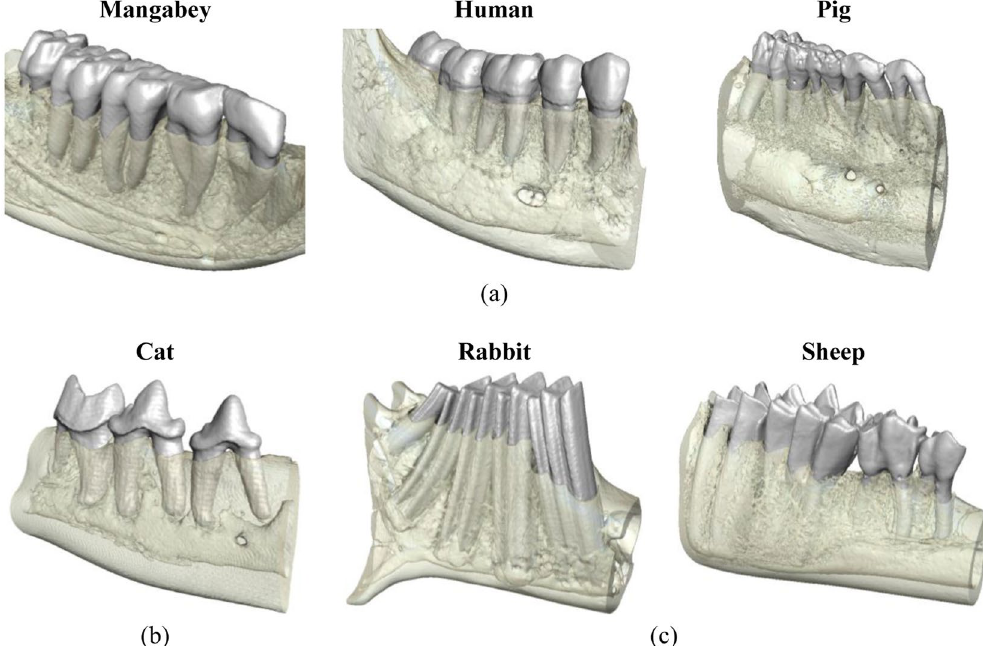
Figure 1. 3D visualisations of the post-canine mandibular corpus of the species included in the histomorphometric analysis. These species display diverse molar shapes and functions, namely: ( a ) molars with flattened or rounded cusps – mangabey, human and pig; ( b ) blade-shaped molars – cat; ( c ) flattened molars with ridges – rabbit and